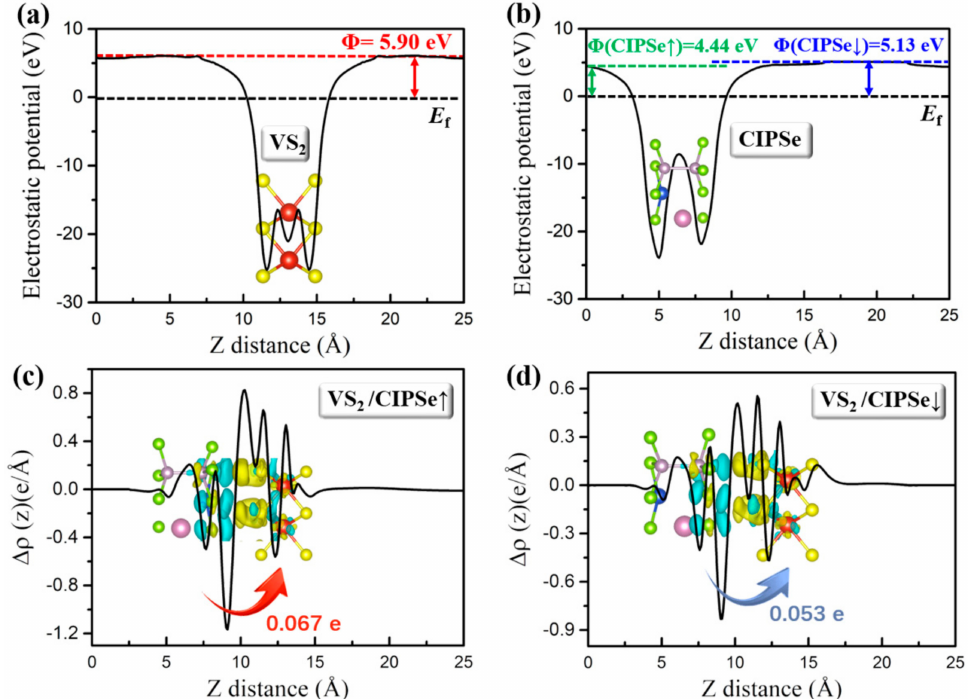
Figure 3. ( a,b ) Electrostatic potential and work functions ( Φ ) for pristine 2H–VS 2 ( a ) and CIPSe ( b ), respectively. The electrostatic potential is defined with respect to Fermi energy (EF). Φ therefore indicates the required energy to remove an electron at Fermi level from the material to a state at rest in the vacuum nearby the surface. ( c , d ) The plane–integrated electron density difference along the vertical direction for the VS 2 /CIPSe ↑ ( c ) and VS 2 /CIPSe ↓ ( d ) heterojunctions. The insets represent the 3D isosurface of differential charge densities for the VS 2 /CIPSe heterojunctions. The yellow and cyan regions represent electron accumulation and depletion, respectively, and the isosurface value is set to be 0.0002 e/Å 3